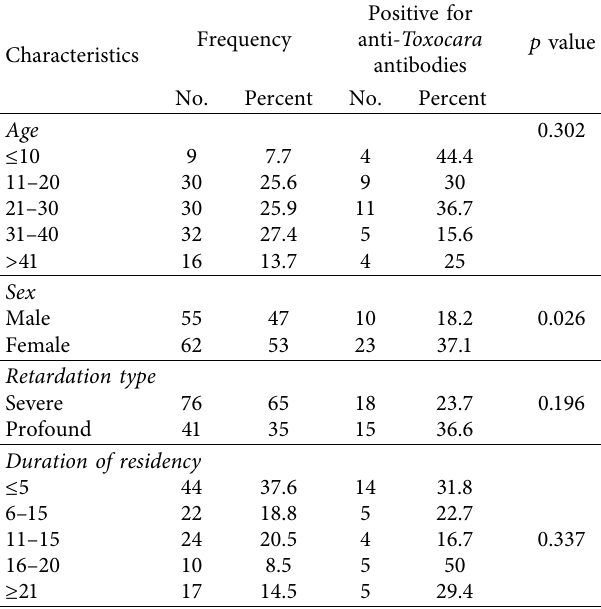
Table 1: Demographic features of the mentally retarded patients and relative seropositivity to Toxocara in Hormozgan Province, Southern Iran.